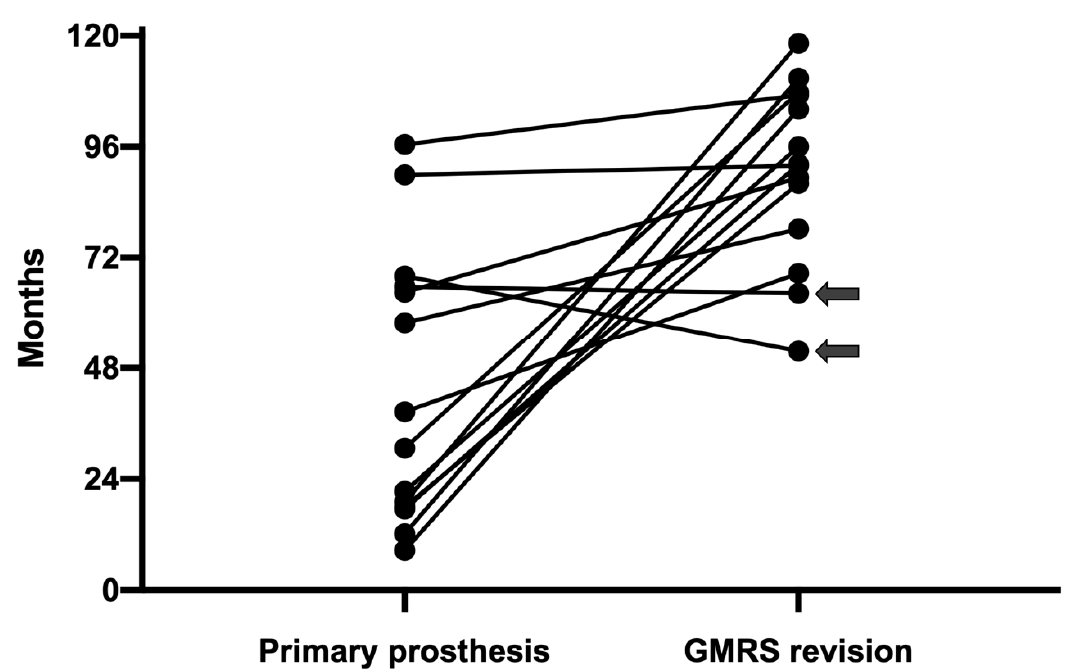
Figure 5. For each of the 14 cases there was a comparison made by connecting the time of aseptic loosening for the primary prosthesis and the follow up months for GMRS revision. Except for the two cases (as arrows marked) without sufficient follow up, all other 12 cases showed longer aseptic loosening free survival in favor of the revision prosthesis.